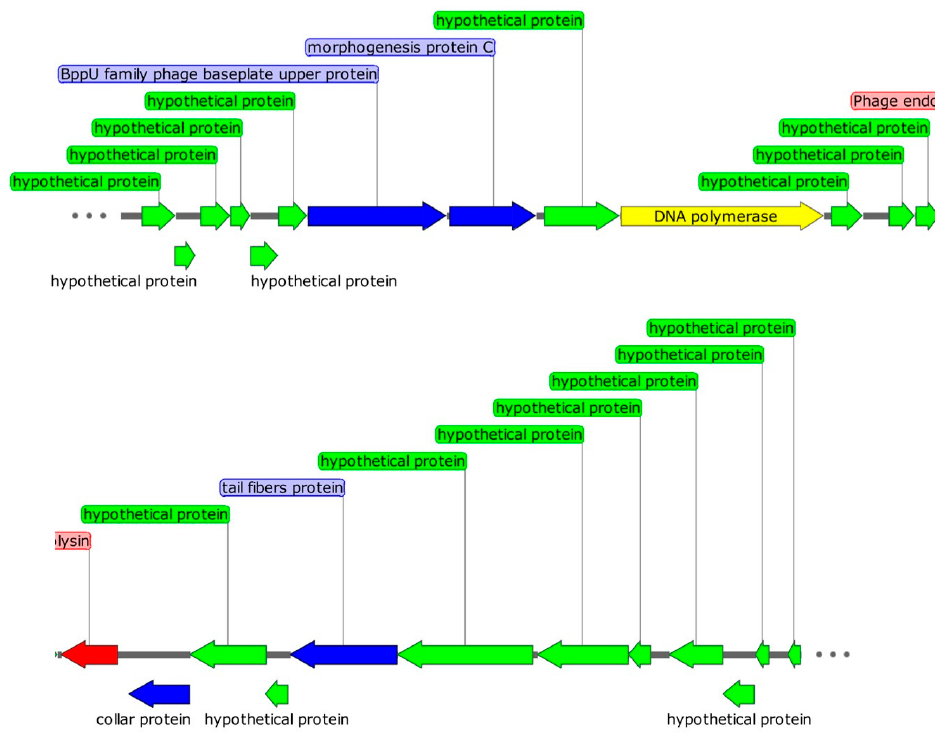
Figure 5. Genome map of phage DCp1. Green arrows represent the genes encoding the hypothetical proteins; yellow arrows represent the genes encoding DNA replication and modification proteins; blue arrows represent the genes encoding structural and packaging proteins; the red arrows represent the genes encoding host lytic proteins.